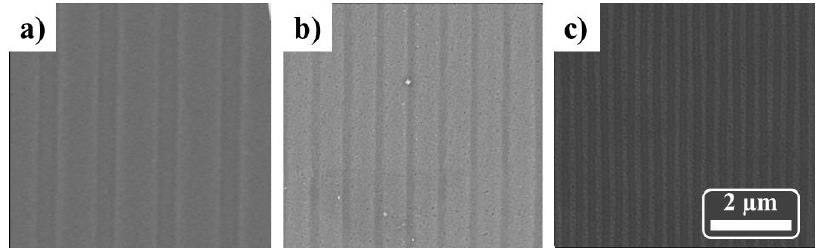
Figure 3. SEM images of stripe patterns on the Al substrate after one imprint step using CD-PS/ML ( a ), DVD-PS/ML ( b ) and BR-PS/ML ( c ) molds. ( a ), DVD-PS/ML ( b ) and BR-PS/ML ( c )